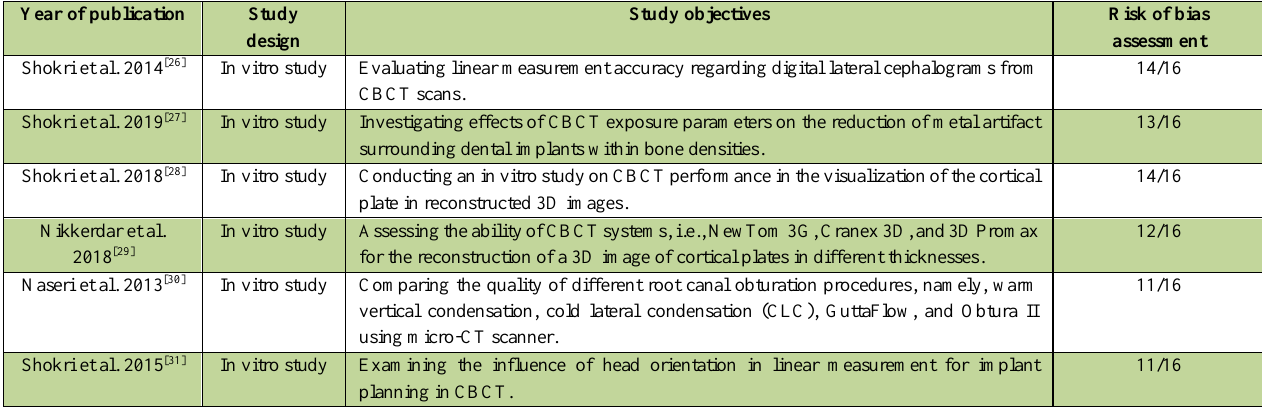
Table 1. Study objectives and risk of bias assessment of selected studies.